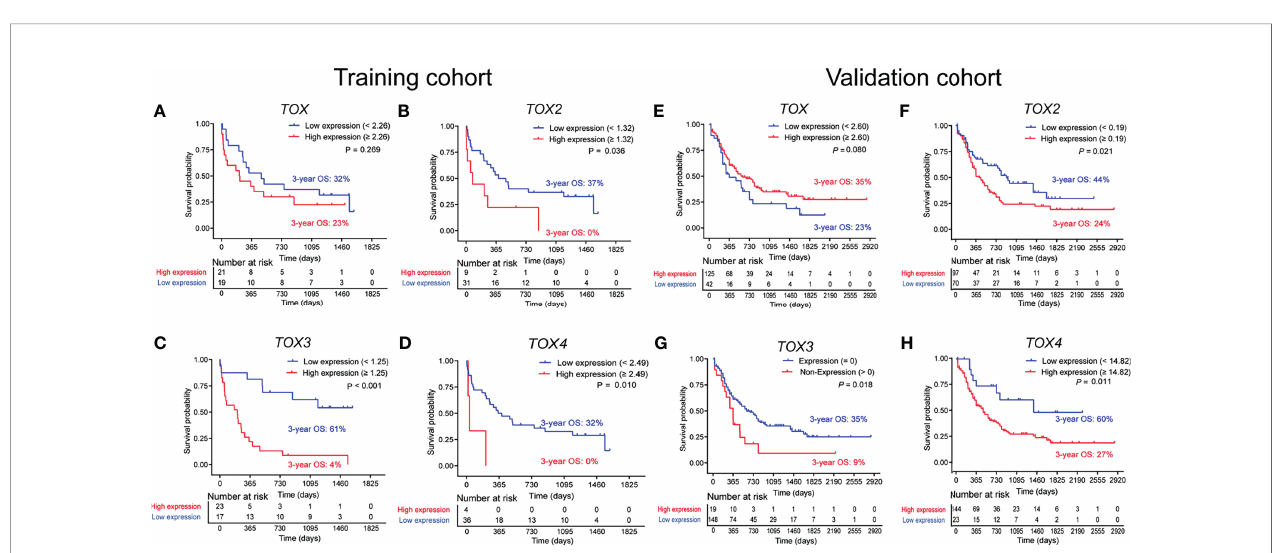
FIGURE 3 | Overall survival (OS) analysis of TOX , TOX2 , TOX3 , and TOX4 from training (A – D) and validation (E – H) cohort. According to optimal cutoff values, the TOX genes were divided into High expression (red line) and Low expression (blue line) groups, which were plotted in Kaplan-Meier curves (top) with the number at risk AML patients (bottom).